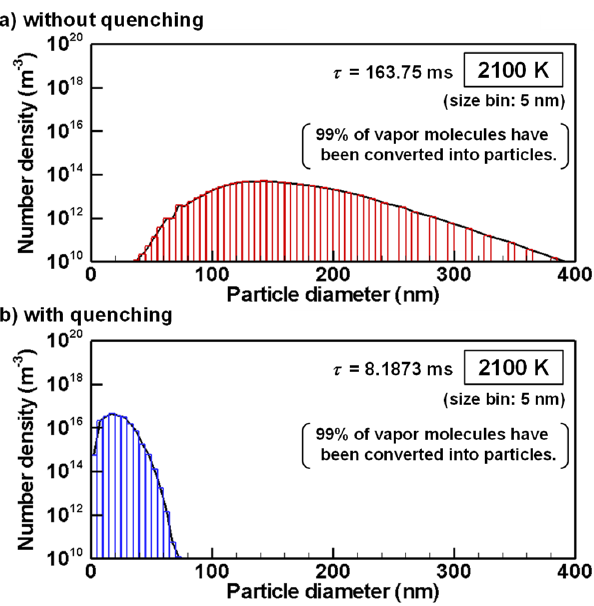
Figure 15. Size distributions of silicon nanoparticles at 2100 K ( a ) without and ( b ) with quenching.